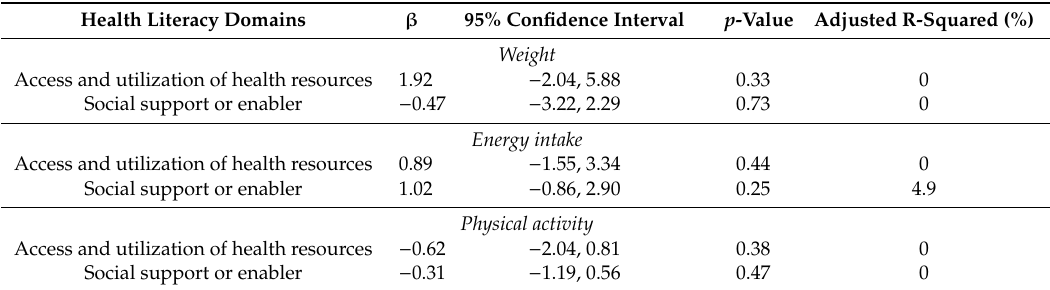
Table 3. Univariate meta-regression of lifestyle interventions in postpartum women on body weight, energy intake, and physical activity by health literacy